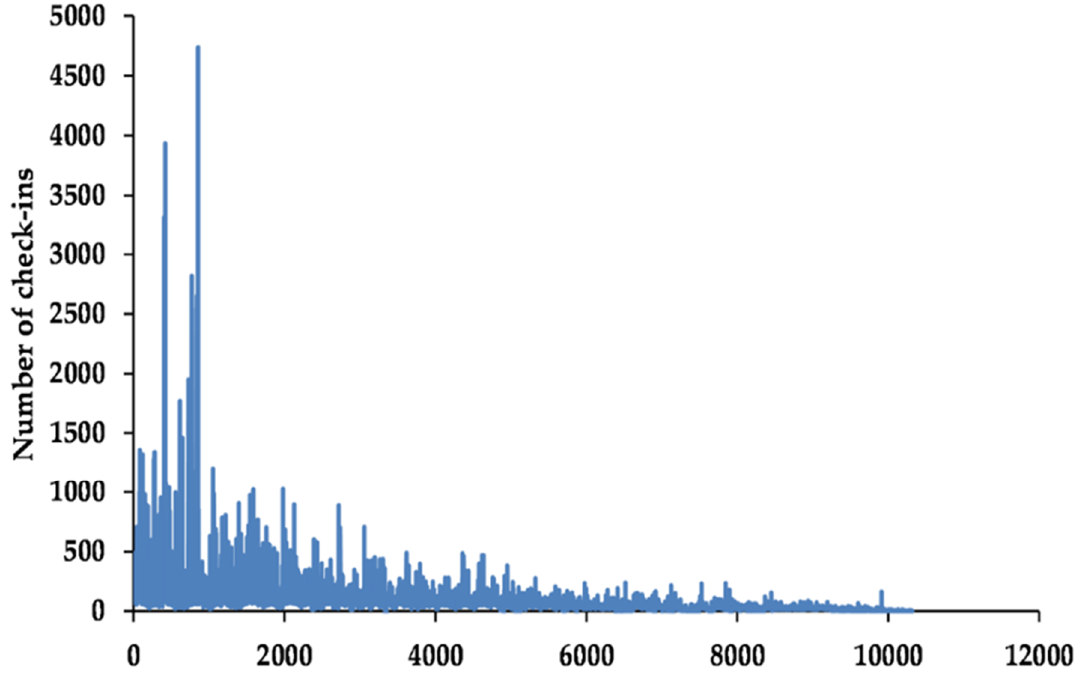
Figure 5. The frequency of check-ins per user.